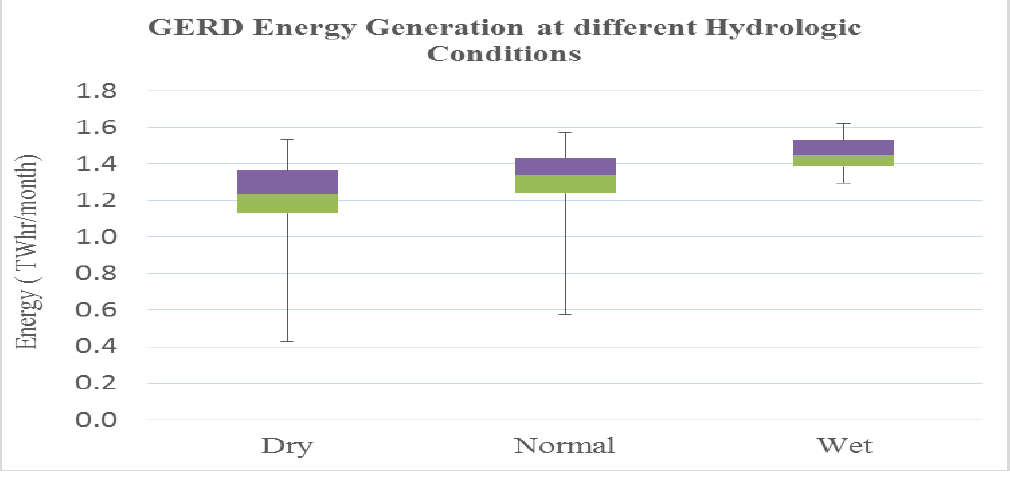
Figure 9. Monthly water levels of the GERD for three hydrologic conditions over the entire 7-year period considered.